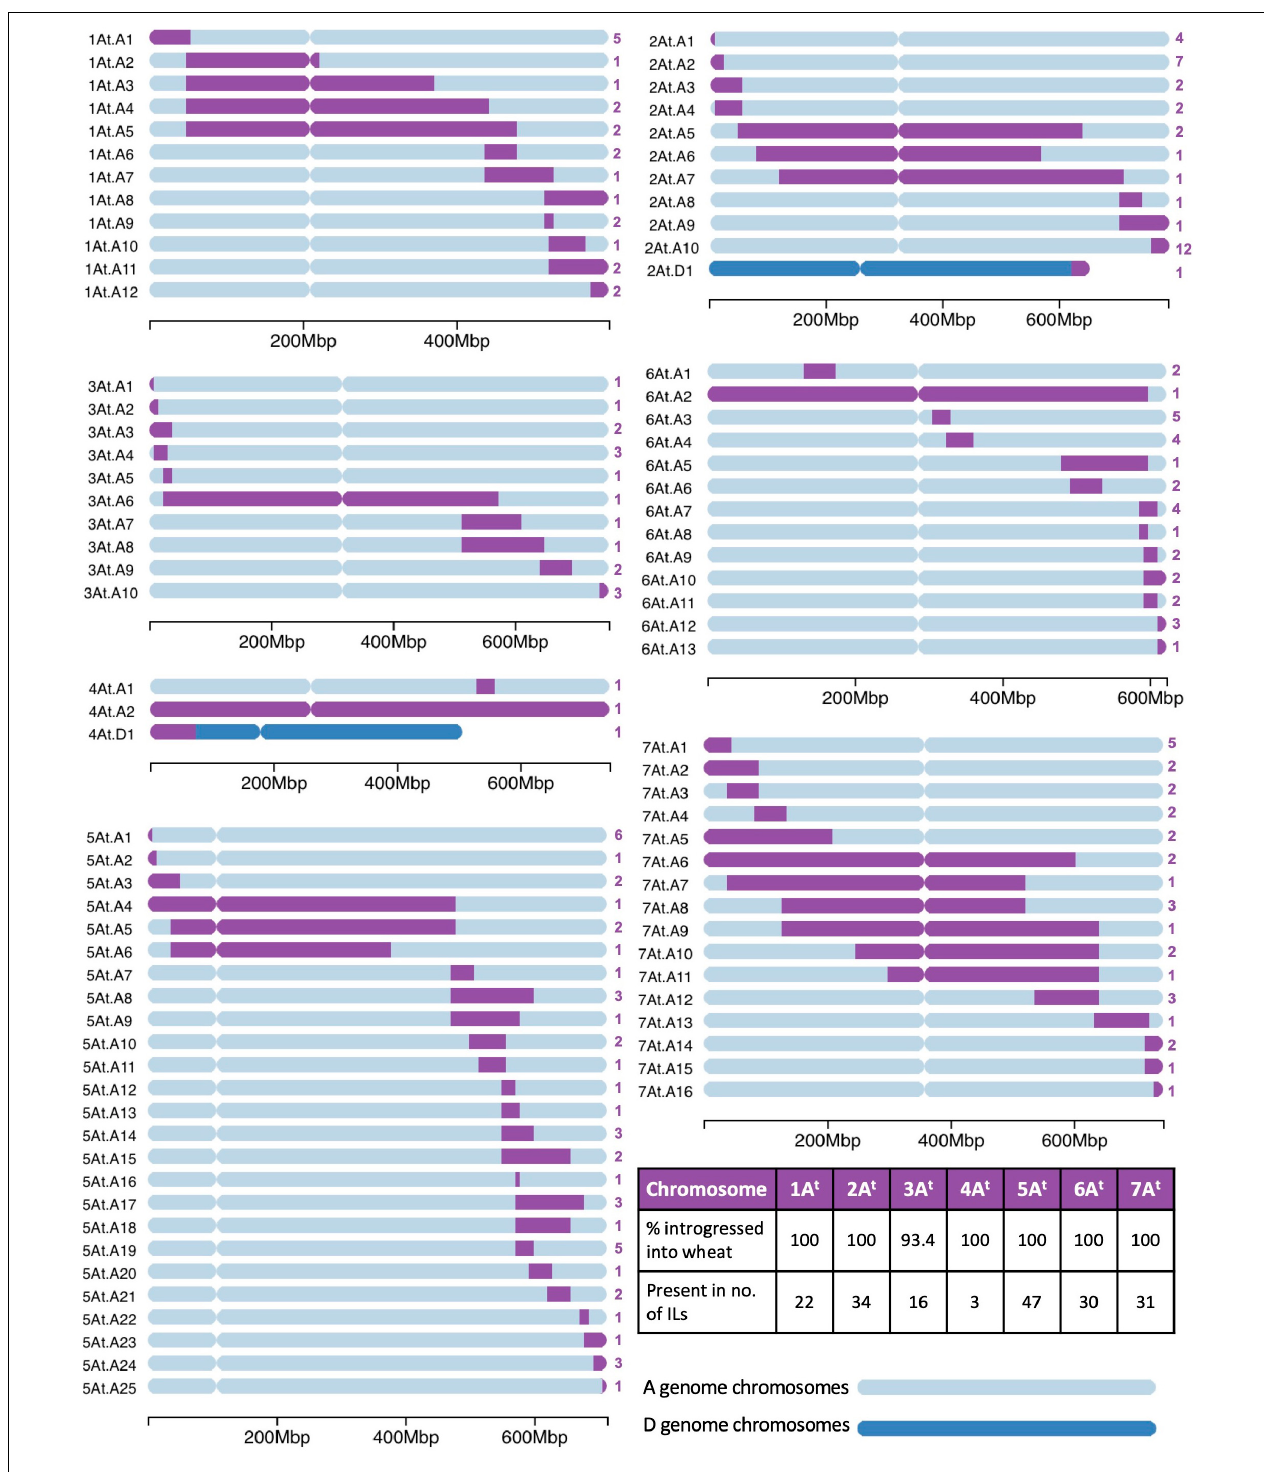
FIGURE 3 | A graphical representation of the size and location of unique introgressions from the A t genome of Triticum timopheevii (purple) in wheat A and D genome chromosomes (shades of blue) for each of the seven linkage groups. On the left of each ideogram is the label of each unique introgression and on the right is the number (in purple) of introgression lines (ILs) the segment is found in. A table on the bottom right shows the percentage of each A t chromosome that has been introgressed into the wheat genome and the number of ILs that contains a homozygous segment from each of the A t chromosomes. A scale at the bottom of each linkage group shows the size of the